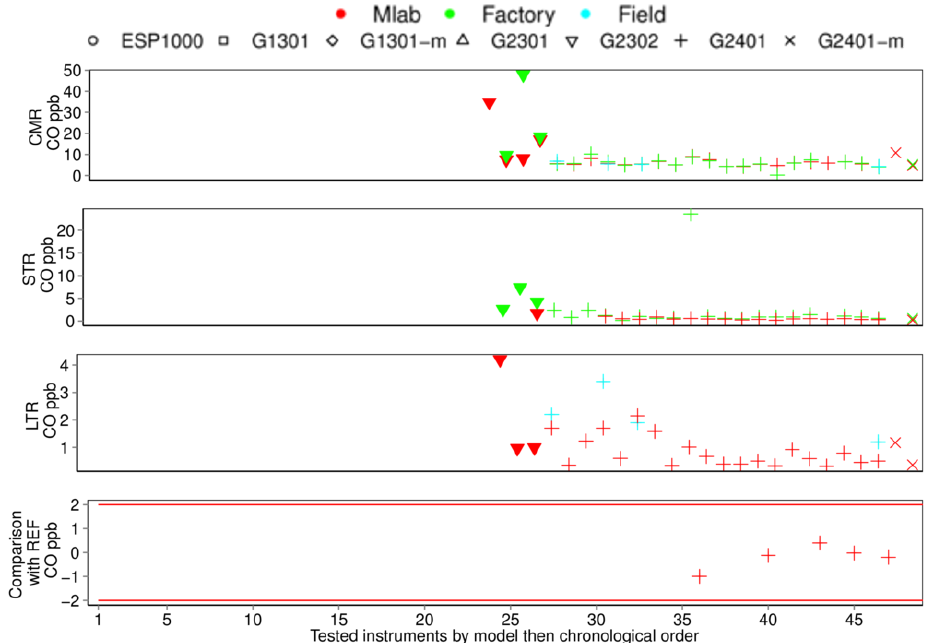
Figure 5. Results for CO. First panel: continuous measurement repeatability (CMR) at the factory (as defined), at the MLab (on the raw data) and in the field (as defined). Second panel: short-term repeatability (STR) at the factory and the MLab. Third panel: long-term repeatability (LTR) at the MLab and in the field. Fourth panel: comparison with reference instrument, average difference at the MLab. The horizontal lines show the WMO compatibility